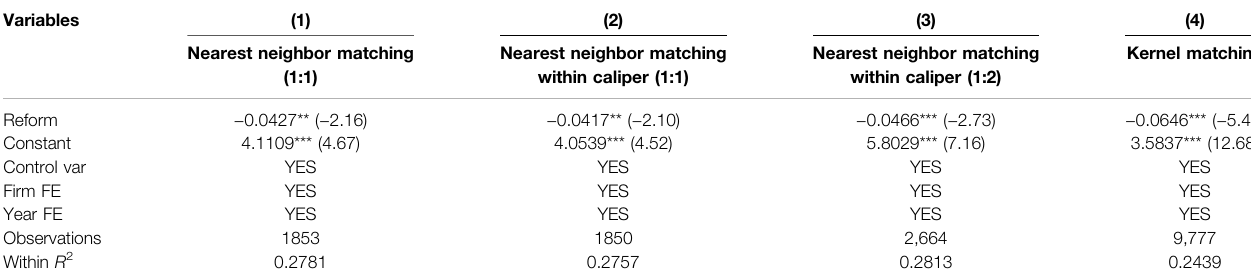
TABLE 7 | Regression results after changing matching method.